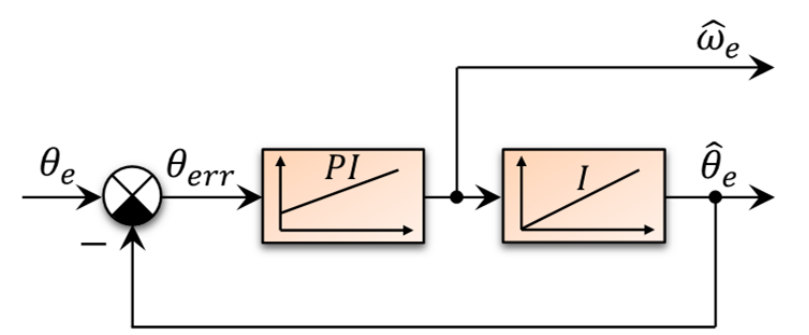
Figure 13. Linearized version of the tracking observer with PLL mechanism.